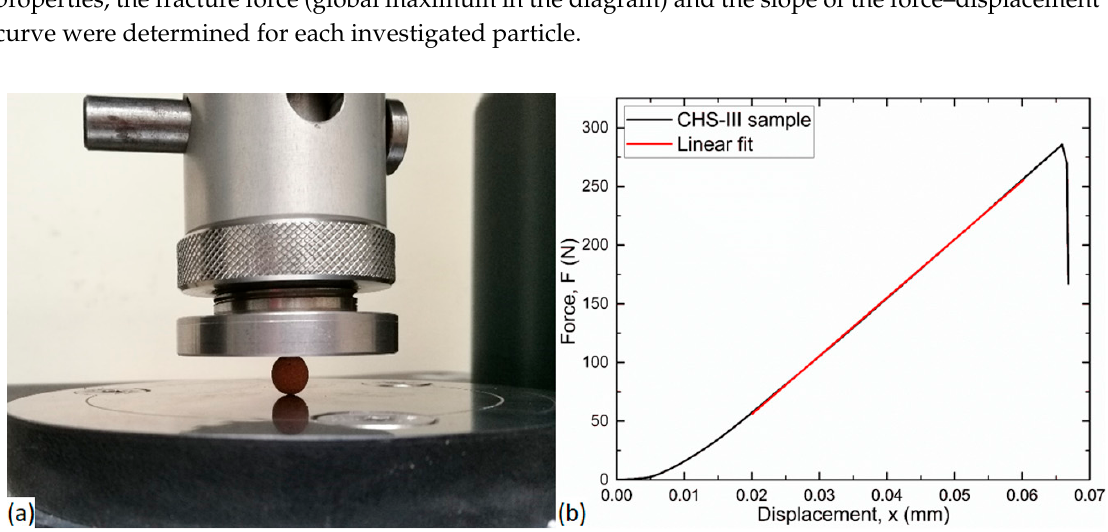
Figure 3. Measure compilation ( a ) and typical force–displacement curve with slope ( b ) of compression test of the individual hollow particle.